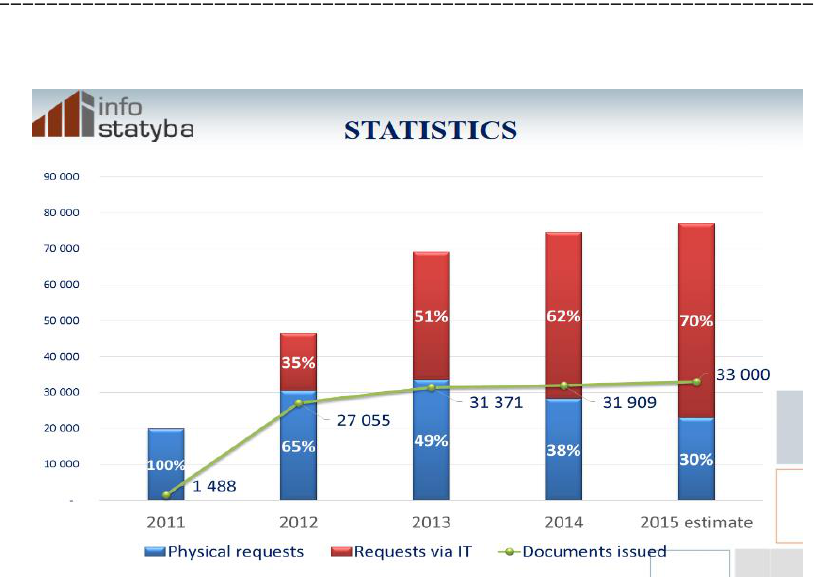
Fig. 3. The dynamics of electronical applications (related to construction processes) (Nalivaikiene,